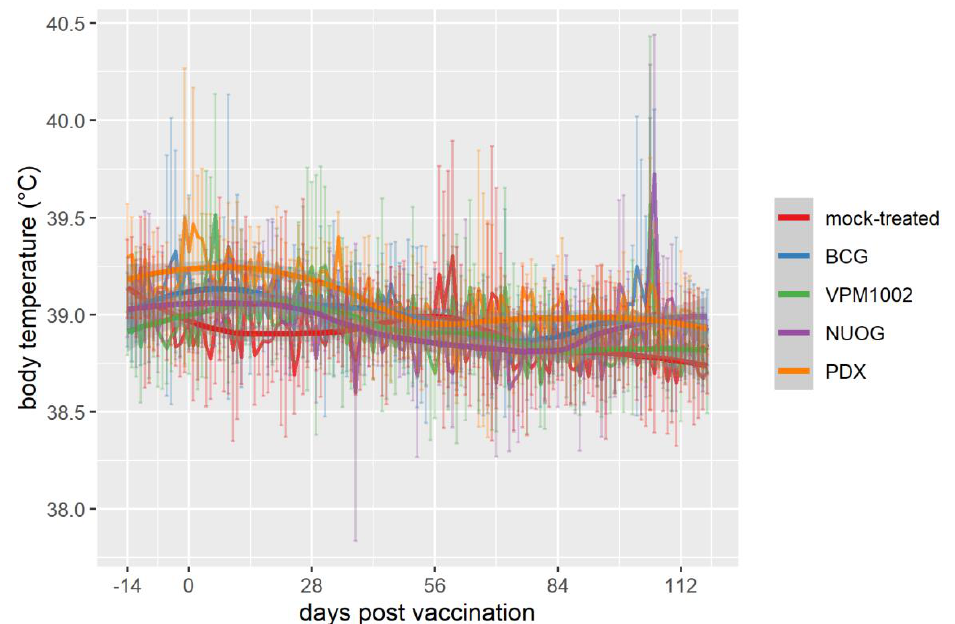
Figure 1. Body temperature of goats vaccinated with either Bacille Calmette-Guérin (BCG), VPM1002, VPM1002 ∆ nuoG (NUOG), VPM1002 ∆ pdx1 (PDX), or mock-treated. Pictured are the mean temper- atures (line plots in the background) and standard deviation (vertical error bars) per group, as well as the temporal development of temperatures smoothed by locally estimated scatterplot smoothing (LOESS) with 95% confidence bands (gray bands). Vaccination had no adverse effect on body weight gain. Differences between groups, apparent two weeks before vaccination, but not statistically significant, remained until the end of the experiment (Figure 2).